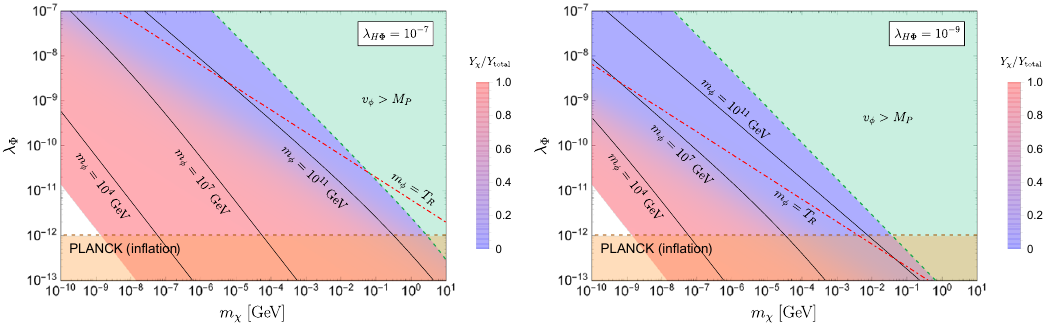
Figure 7 . Parameter space in the ( m χ , λ Φ ) plane where the correct relic abundance of dark matter is realized by the non-thermal production (the freeze-in and the inflaton decay). The portal coupling is chosen as λ = 10 − 7 (left) and λ = 10 − 9 (right). The freeze-in production is dominant in H Φ H Φ the red region and the inflaton decay dominant in the blue region. The lower orange region is not consistent with the inflation observables as in figure 6. In the green region, the scalar VEV becomes